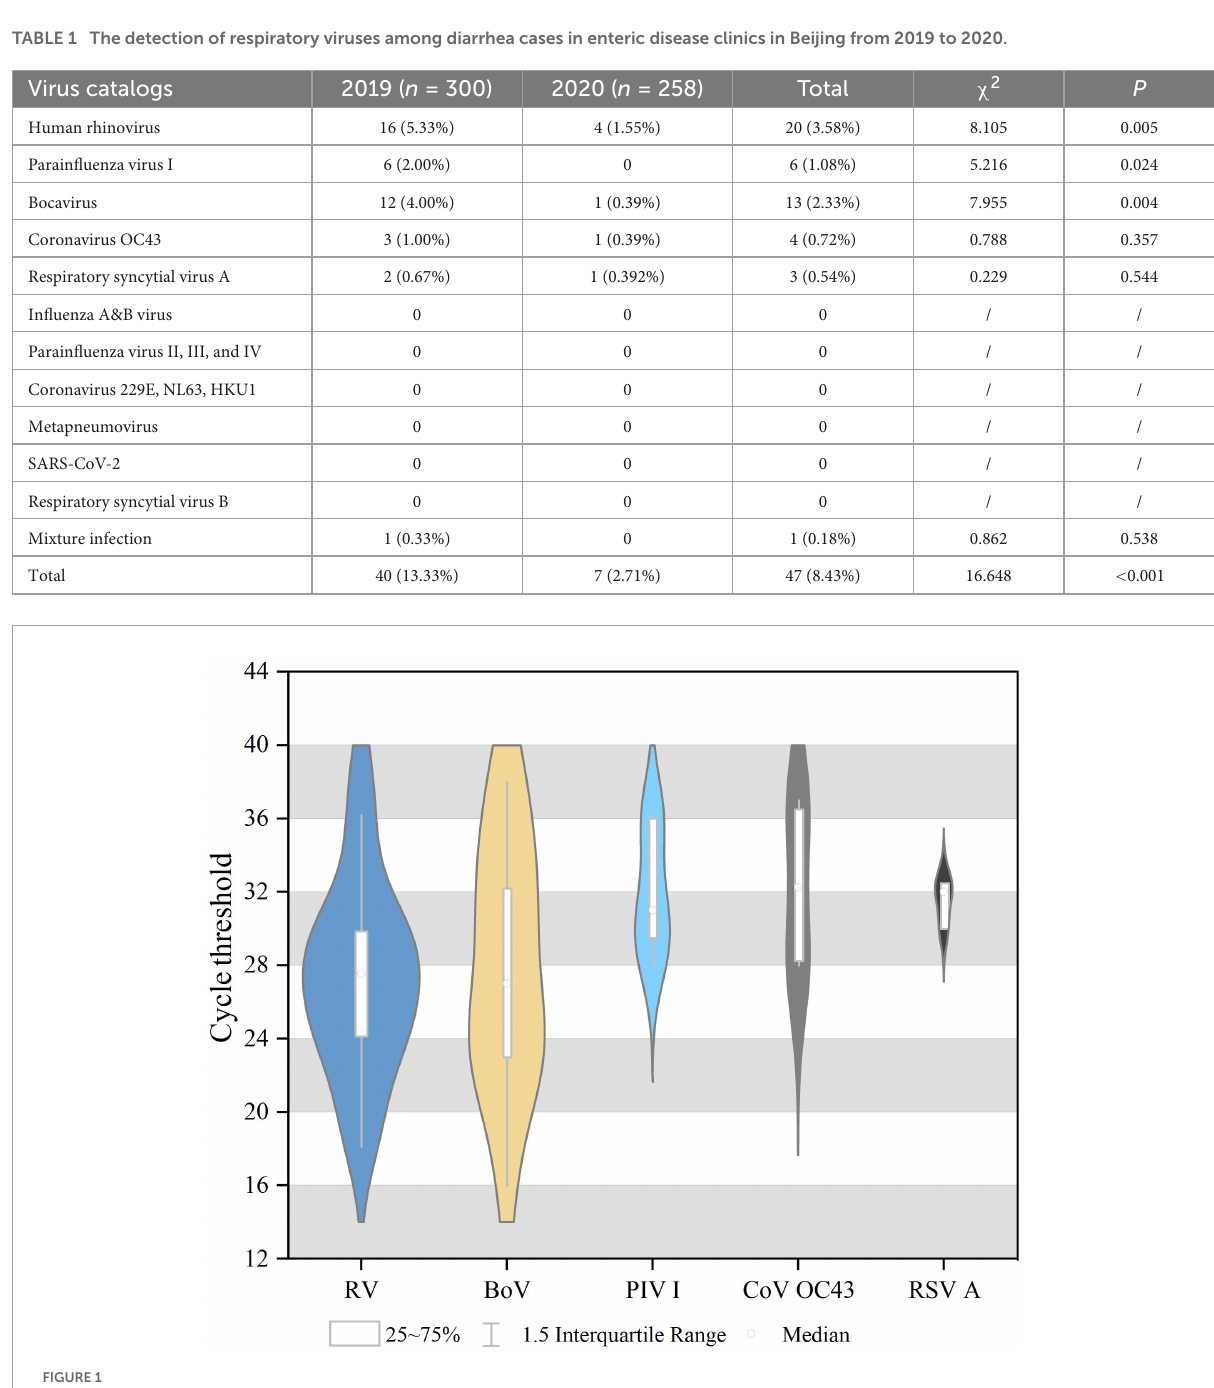
FIGURE1 The cycle threshold (CT) values of respiratory viruses among diarrhea patients in acute enteric disease clinics in Beijing from 2019 to